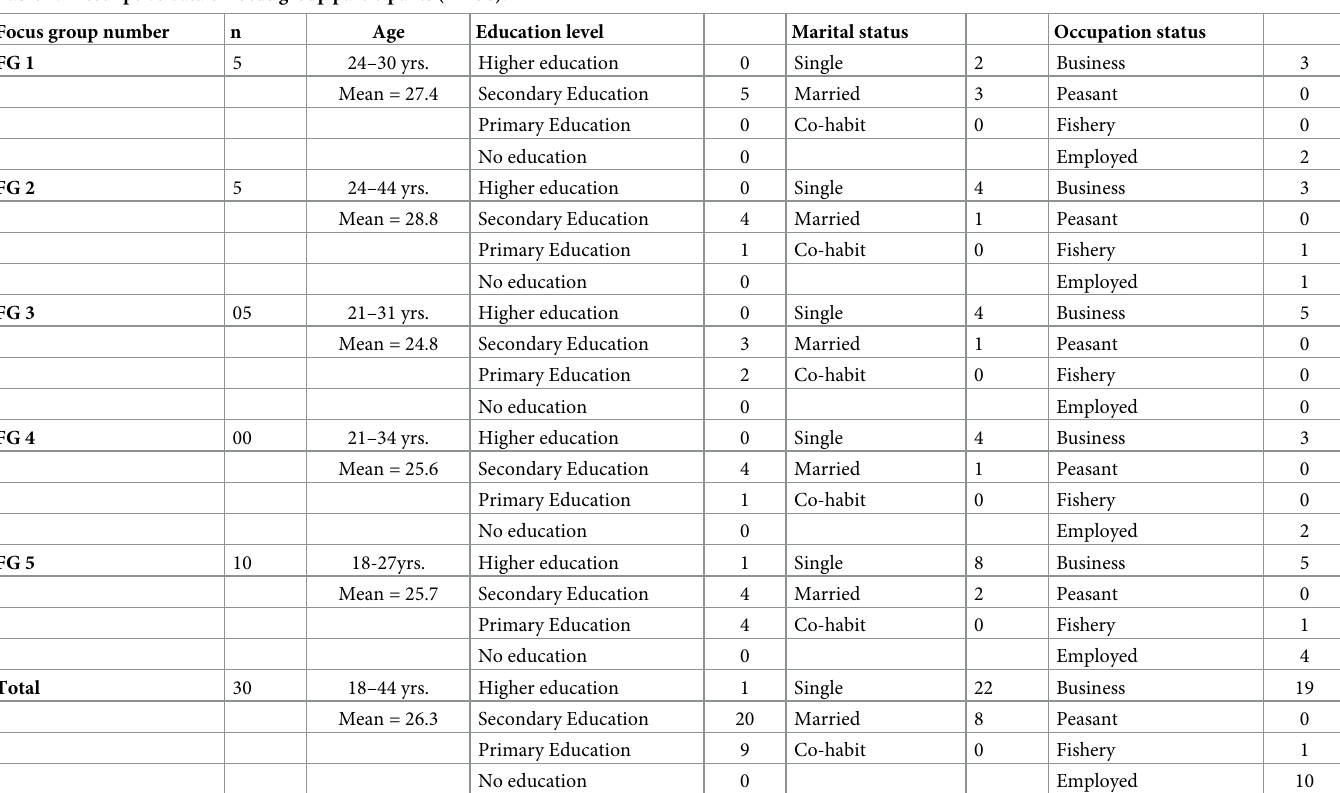
Table 2. Descriptive data of focus group participants (n =